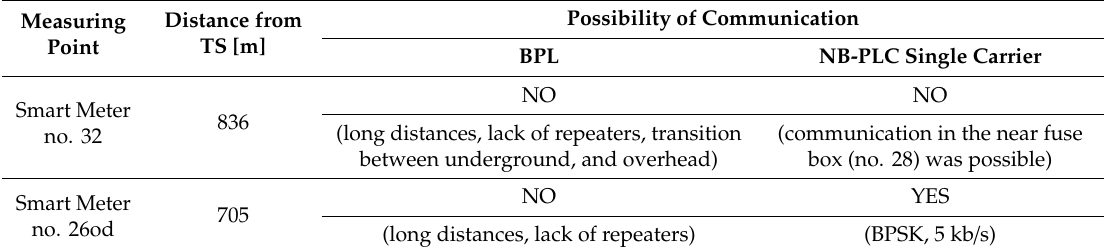
Table 3. Possibility of BPL and NB-PLC communication—without